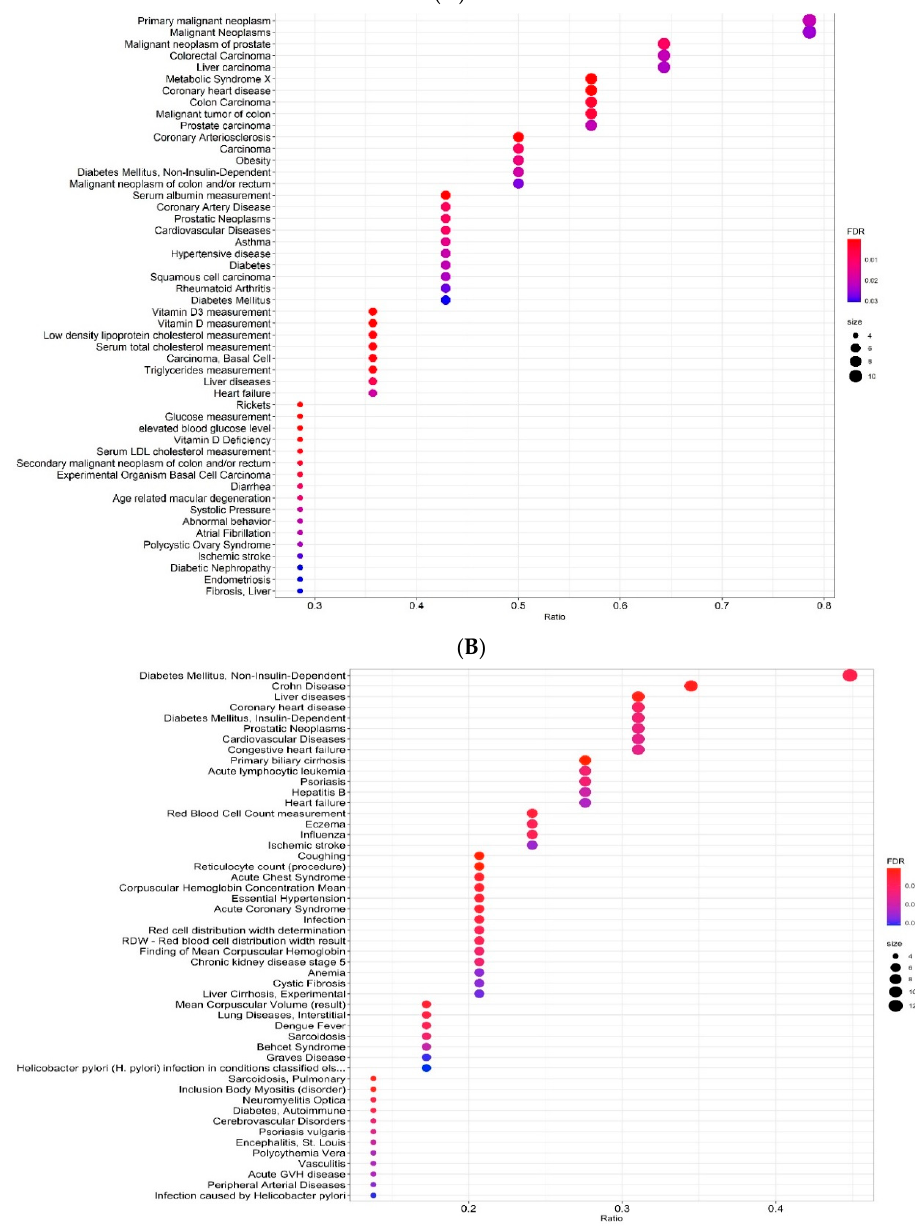
Figure 5 . Enrichment Analysis of the genes associated with a VD deficiency ( A ) and COVID-19 ( B ). Representation of the existing association between the diseases and the enriched genes, based on the ratio (input genes relative/associated) and the FDR. The size of the dots refers to the number of genes enriched for that disease (the greater the number of genes, the larger the dot). The FDR is defined by a color scale, the closer it is to red, the greater the FDR value and the greater the associ-